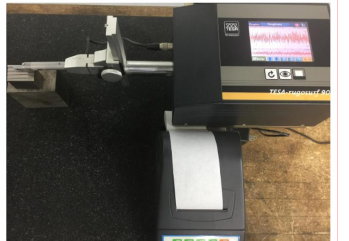
Figure 3. Test rig for measuring surface